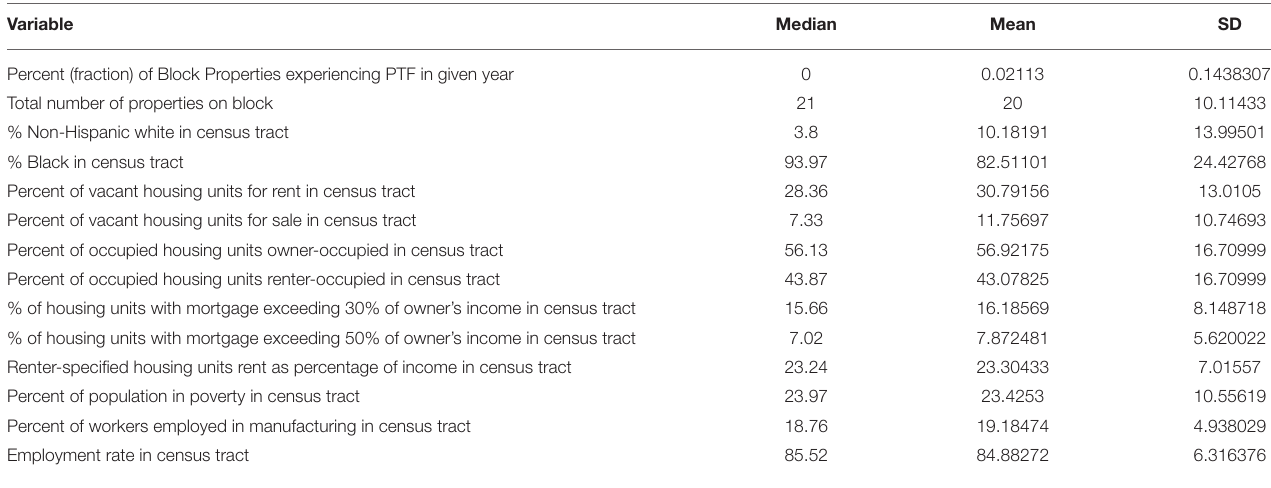
TABLE 2 | Summary statistics of covariates.